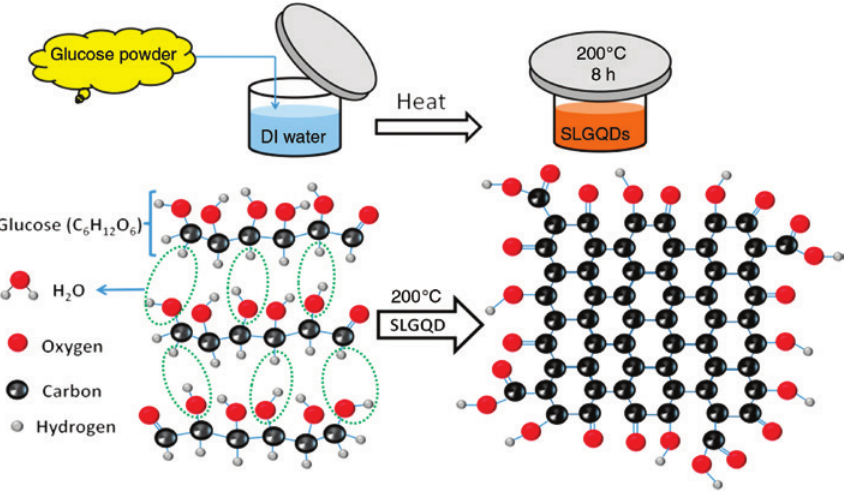
Figure 15: Formation mechanism of the SLGQDs via a hydrothermal method at 200 ° C for 8 h (reprinted/reproduced with the permission of Ref. [102], copyright 2017, Elsevier